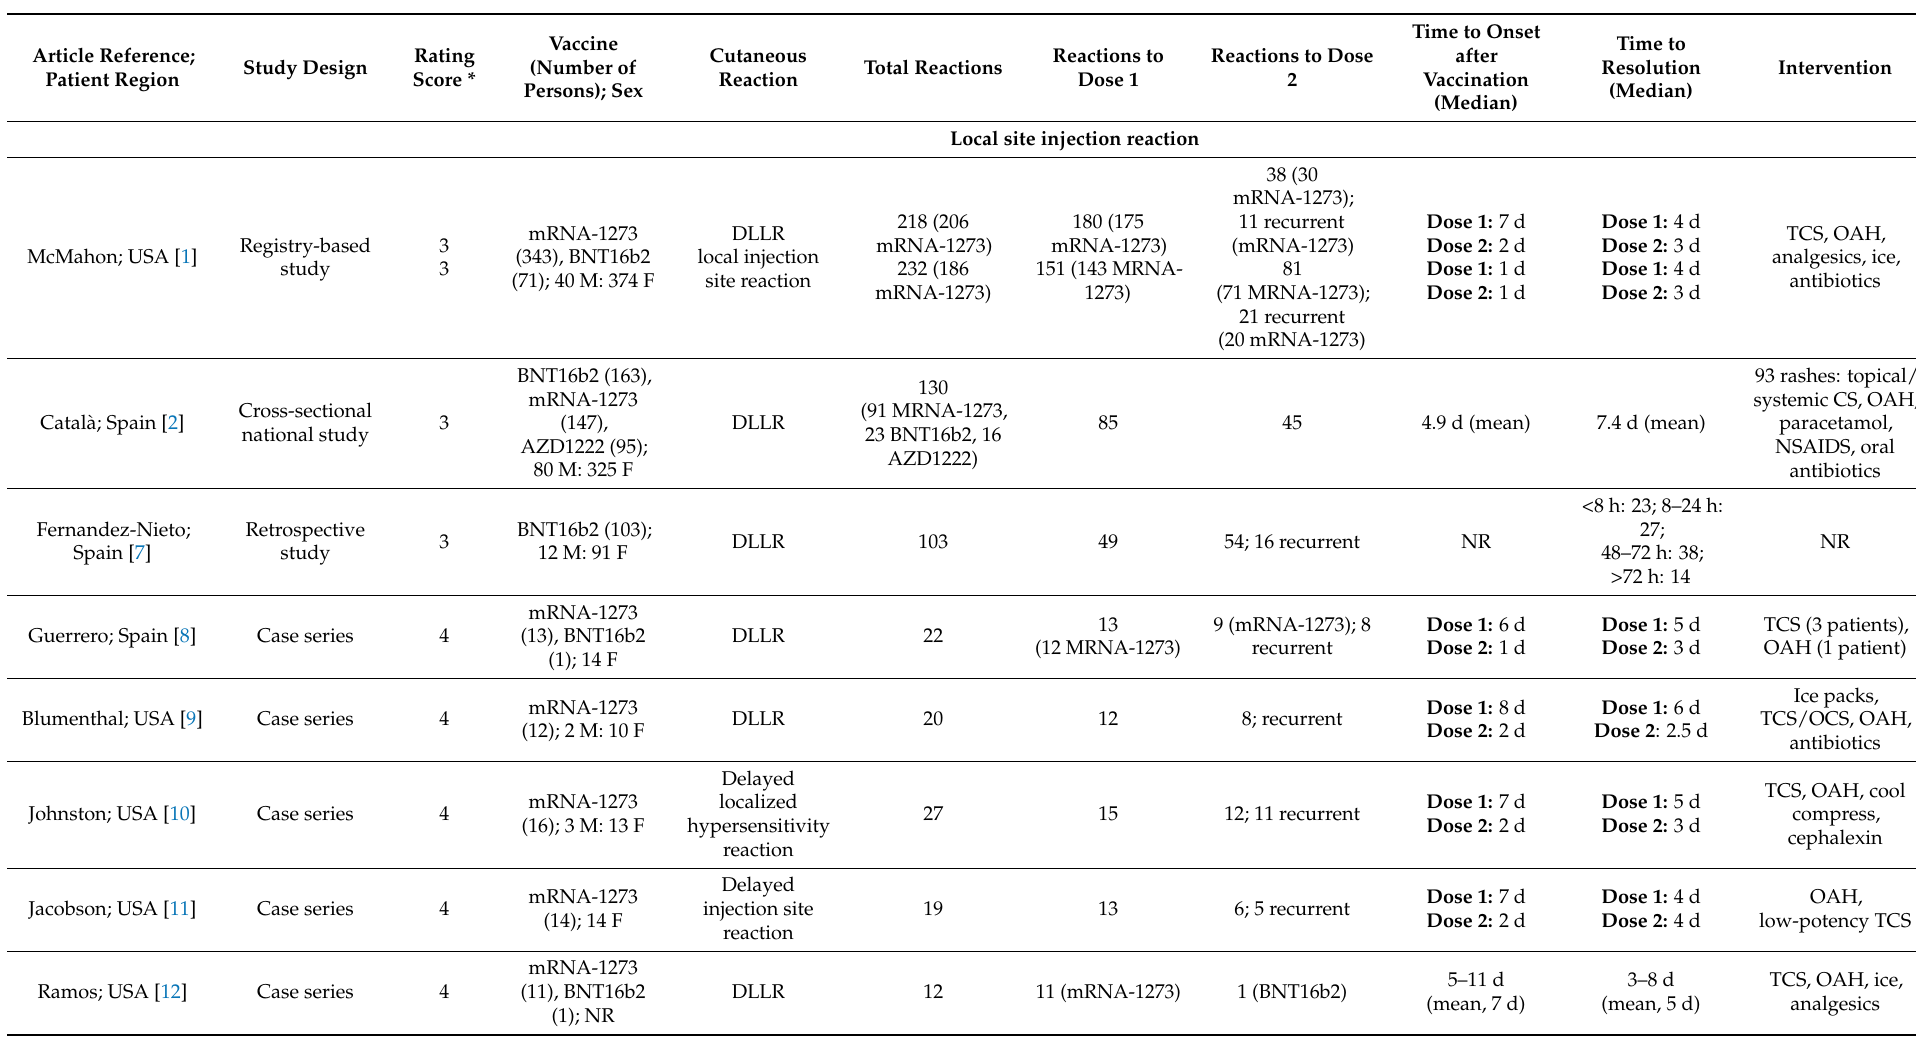
Table 1. Cutaneous reactions to mRNA and AZD1222 COVID-19 vaccines reported in the nontrial